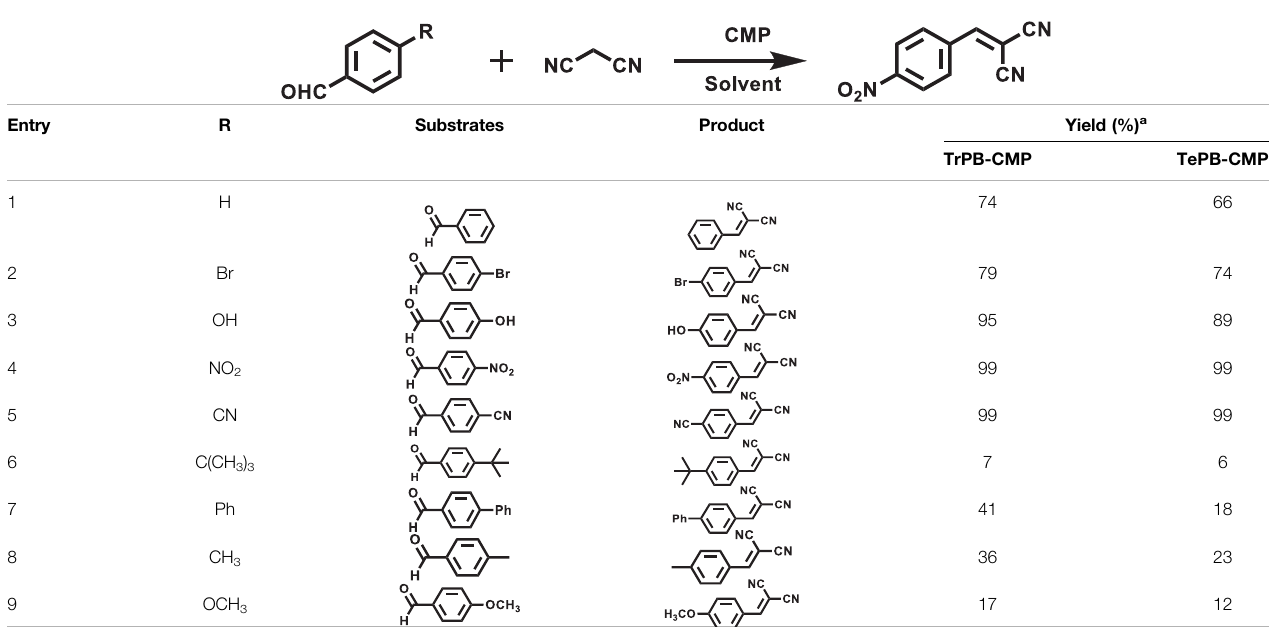
TABLE 1 | Catalytic activities of TrPB-CMP or TePB-CMP toward Knoevenagel condensation with different aromatic aldehyde substrates.